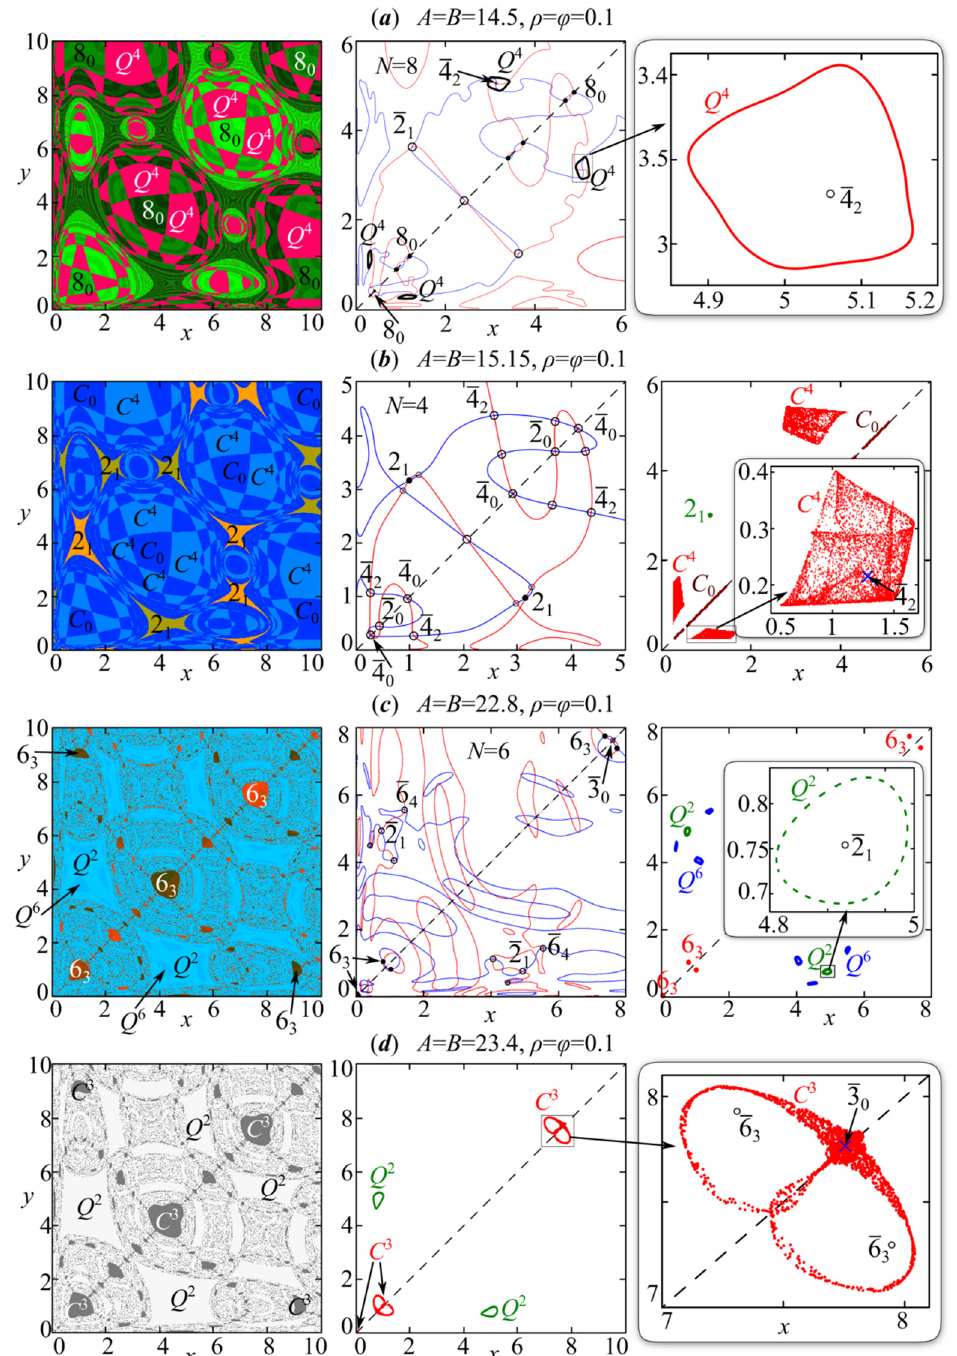
Figure 8. The first column is attraction basins of stable dynamics modes. The second one (except for ( d )) is system (14) nullclines. The third one presents coexisting attractors with their enlarged fragments. ( a , c ) are the closed invariant curves. The discrete Shilnikov-shape attractor is ( b ) and the Lorentz-shape one, ( d ). Stable fixed points are designated as T τ and are marked by black circles. Unstable points are designated as T τ and shown by white circles or crosses. T is the period and subscript τ is the phase shift of variable x n relative to y n . Attraction basins of different colors, marked in the same way, correspond to oscillations with the different initial phases.